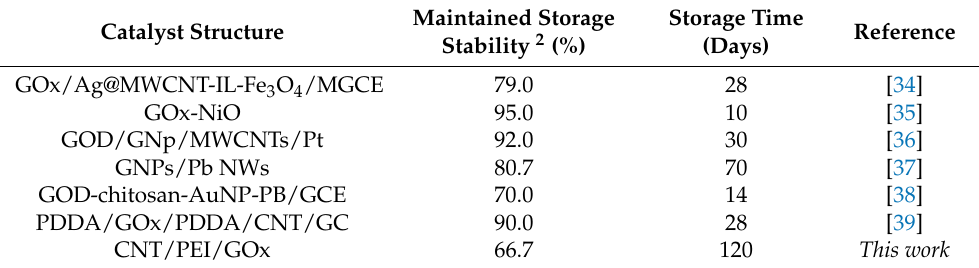
Table 3. Comparison of long-term storage stability from several glucose biosensor catalysts 1